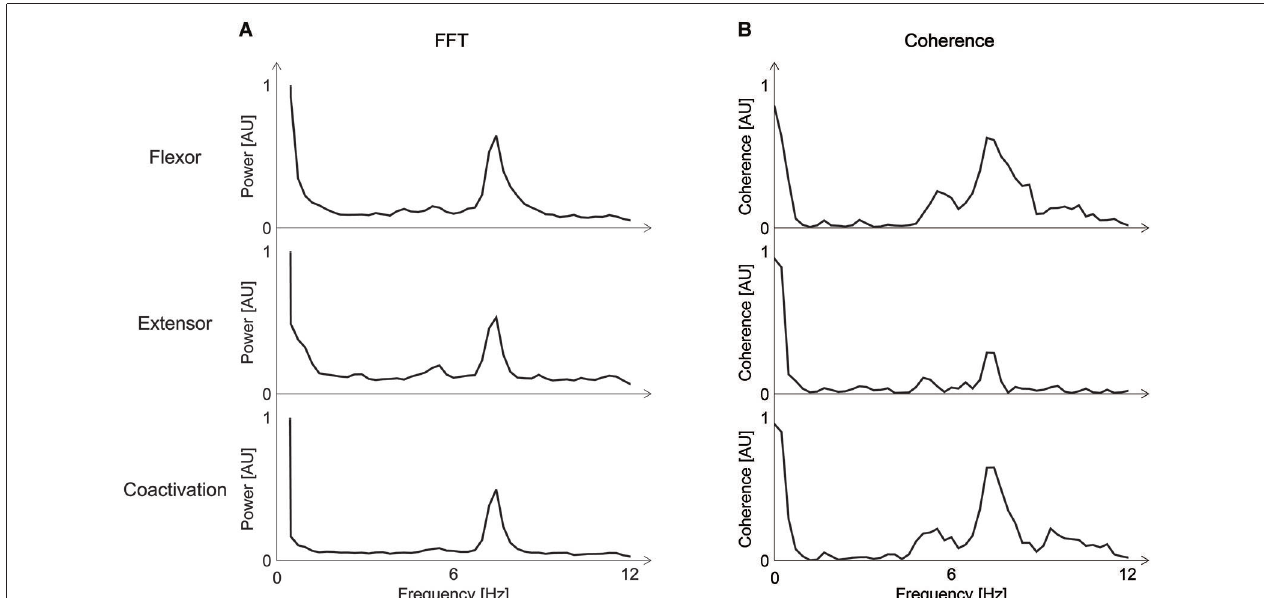
rows), and coherence between the coactivation and the accelerometer signal (third row). Coherence is highest at the same frequency of about 7 Hz found with the FFT. AU = arbitrary units; FFT = Fourier transform; EMG =